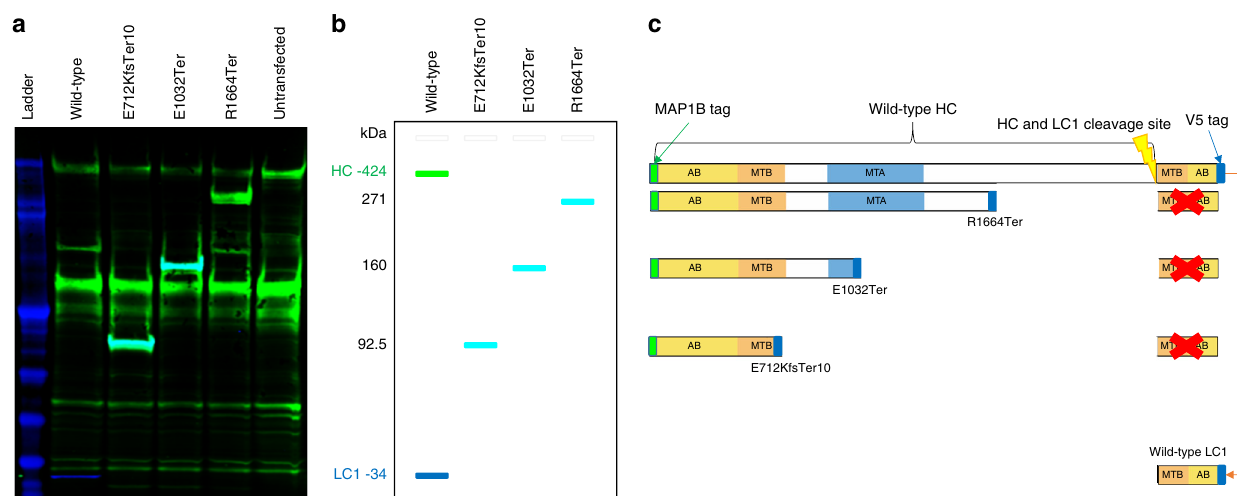
Fig. 4 Western blot of antibody binding to wild-type and truncated MAP1B proteins. a An image, from the Odyssey system, where the colour coded infrared fl uorescent signals from the 700 nm channel (V5 antibody signal — blue) and the 800 nm channel (MAP1B antibody signal — green) are taken from the same blot; cyan indicates where both antibody signals overlap. See Supplementary Figure 7 for the individual V5 and MAP1B antibody signal greyscale pictures. b A schematic diagram of what each band on the western blot represents in the context of protein size (heavy chain (HC), light chain 1 (LC1) and truncated proteins). c A schematic diagram of truncated MAP1B and an indication of whether the anti-V5 or anti-MAP1B antibodies bind the protein product. The wild-type HC is only recognised by the anti-MAP1B antibody (green), and the wild-type LC1 is only recognised by the anti-V5 antibody (blue), while both anti-MAP1B and anti-V5 antibodies bind to all three truncated protein products as they contain both the MAP1B (amino acids 6-31) and V5 tags (cyan bands in b ). The red X indicates that the LC1 is not produced as a consequence of the MAP1B truncation. AB actin-binding domain, MTA microtubule assembly helping site, putative, MTB microtubule-binding